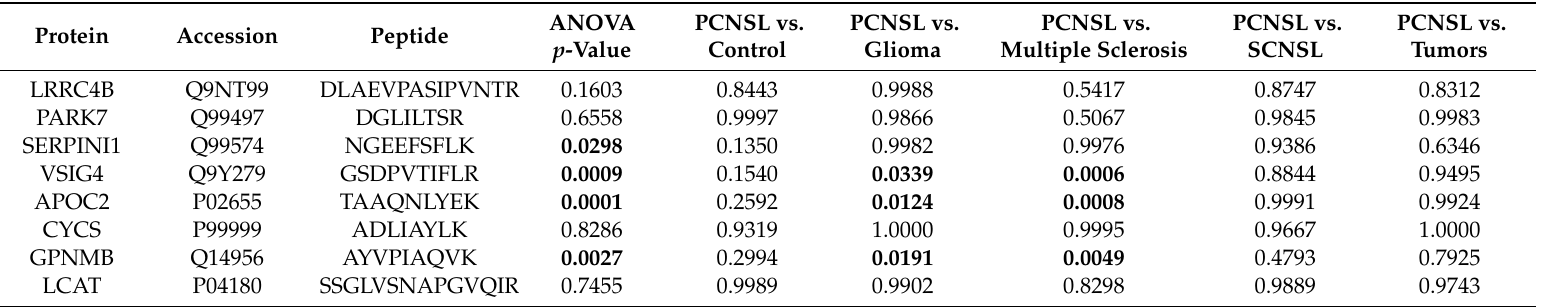
Table 6. Results from the SRM analysis of the independent validation cohort. The values in bold letters assign significant abundant